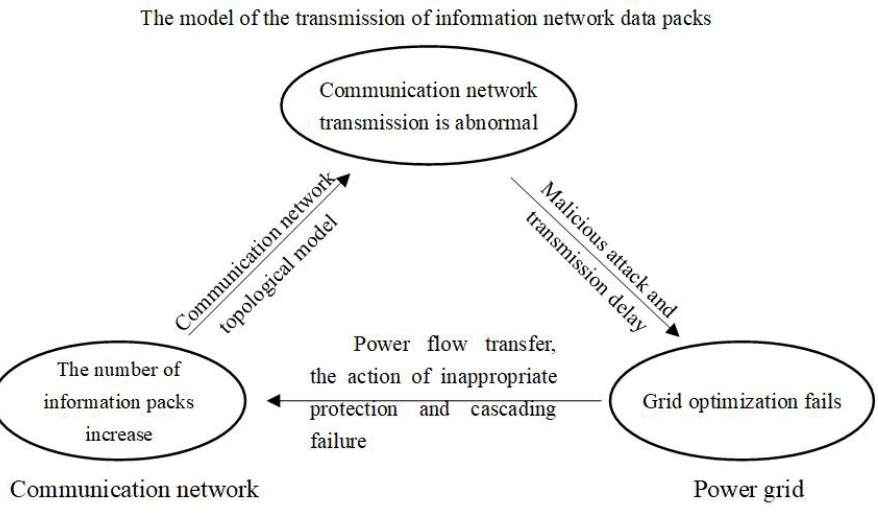
Figure 5. Mechanism diagram of cascading failure propagation under the interaction of two net- works [25].